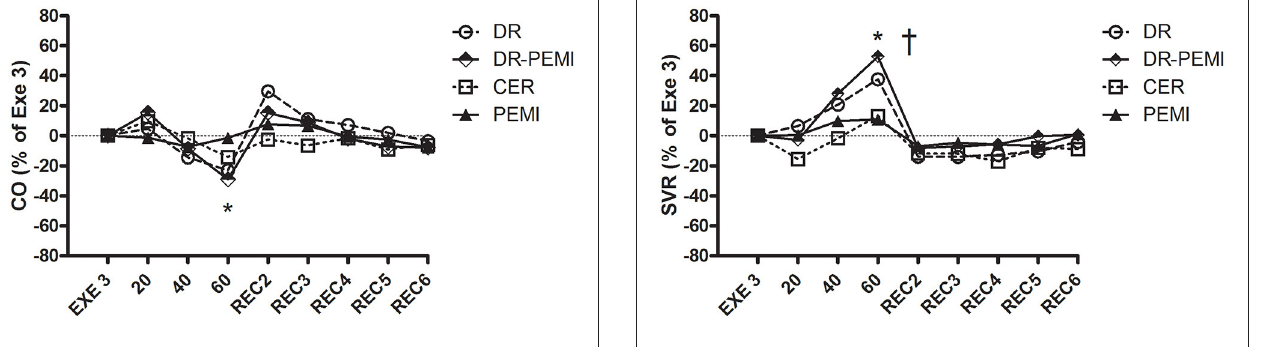
FIGURE 4 | CO time courses during all four tests. Values are means ± SD percentages at the end of handgrip (EXE3). * = P < 0.05 vs. EXE3.